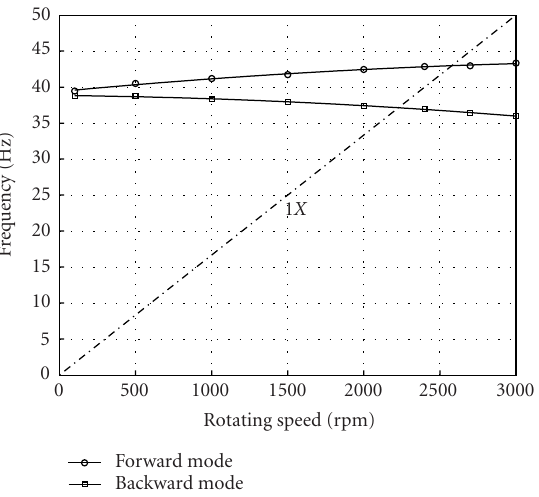
Figure 8: Campbell diagram of the rotor.